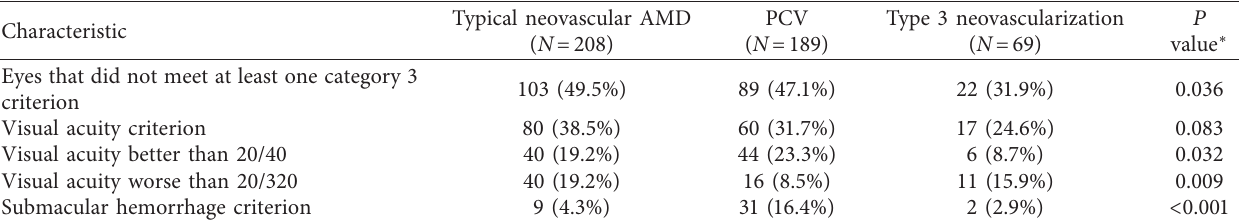
Figure 1: Fundus photography and optical coherence tomography findings of eyes which did not satisfy the eligible criteria. (a) Best- Table 5: Comparison of the proportion of eyes that did not meet category 3 criteria among the three subtypes of neovascular age-related macular